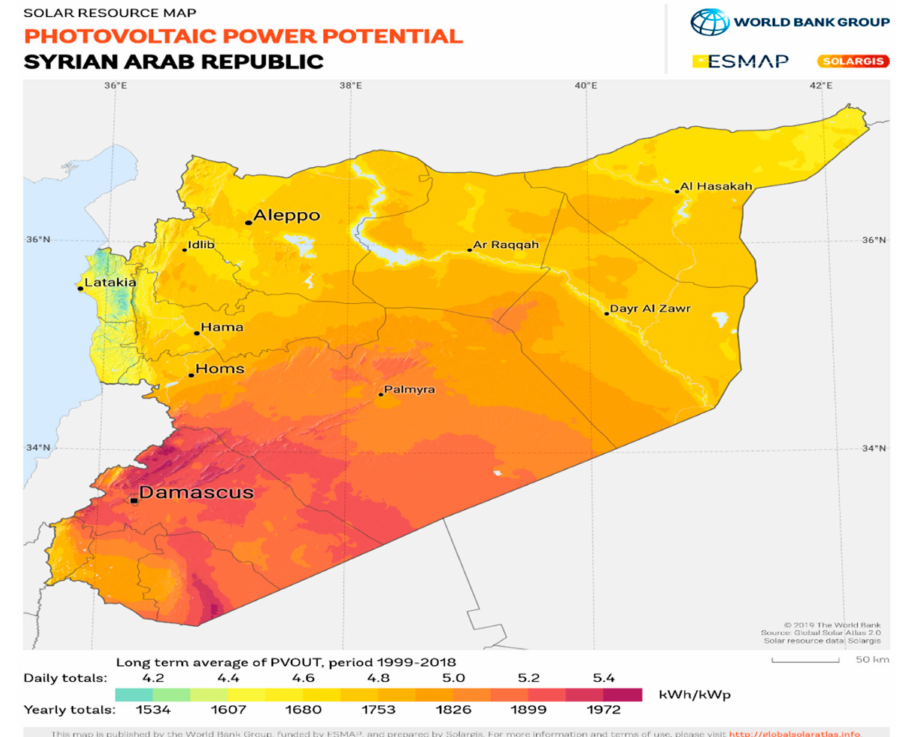
Figure 8. Photovoltaic power potential in Syria [42].